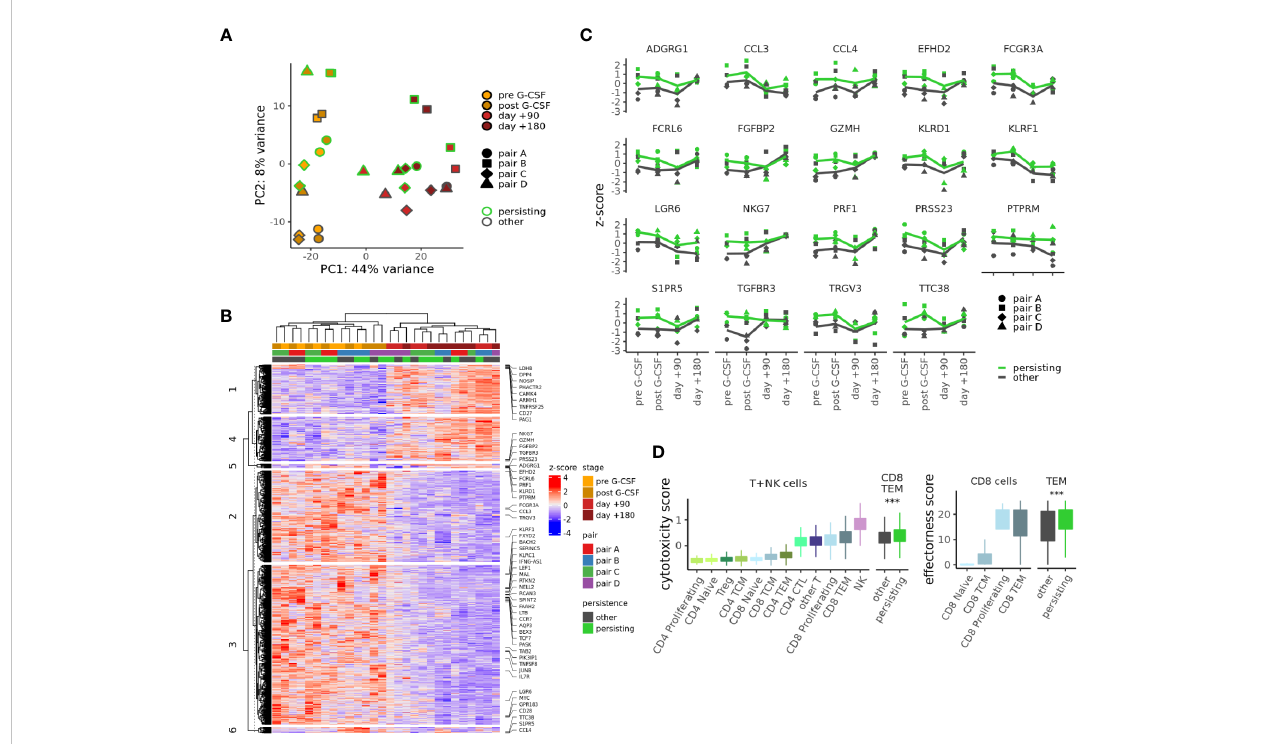
FIGURE 4 Distinct transcriptional dynamics of persisting T cell clonotypes. (A) PCA of pseudobulk gene expression in CD8TEM cells using 989 genes differentially expressed (adj. p-value < .01, abs. log2 fold change > 0.5) between donors and recipients or between persisting and other cells. (B) Gene expression heatmap for the genes used in (A) ; 54 genes differentially expressed between persisting and other cells are highlighted. (C) Expression of selected genes differentially expressed between persisting and other CD8TEM cells at adjusted p-value < 0.01 and log2 fold change >0.5. (D) Cytotoxicity (left) and effectorness scores (right) for different T- or NK cell subpopulations. p-values from t-test, ***p < 0.001. CTL, cytotoxic T